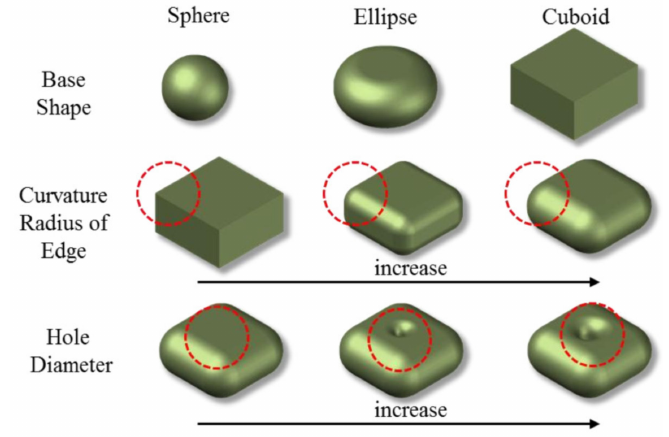
Figure 2. Parameters of the void